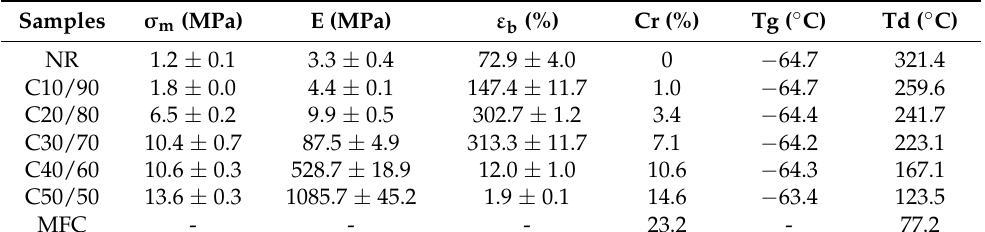
Table 2. Tensile strength ( σ m ), Young’s Modulus (E), elongation at break ( ε b ), degree of crystallinity (Cr), glass transition temperature (Tg), and decomposition temperature (Td) at mass loss of 5% of NR, MFC–NR composites, and MFC.